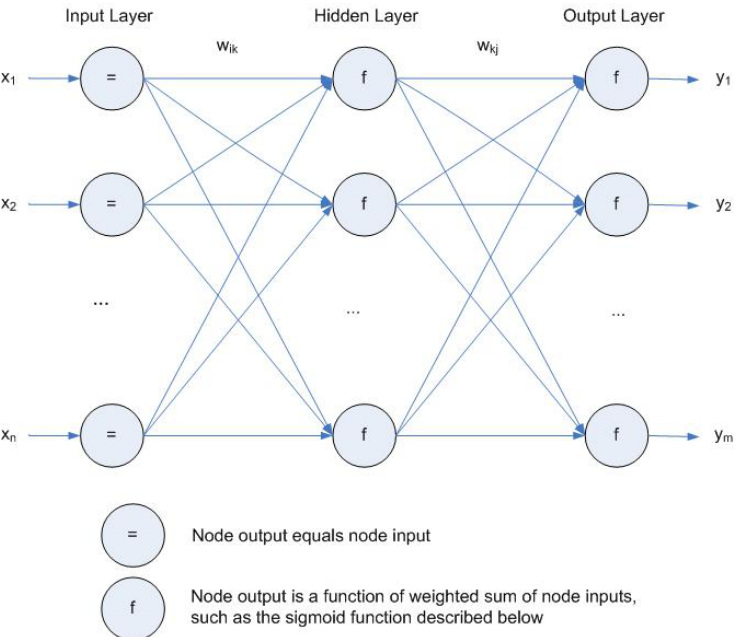
Figure 1. MLP network